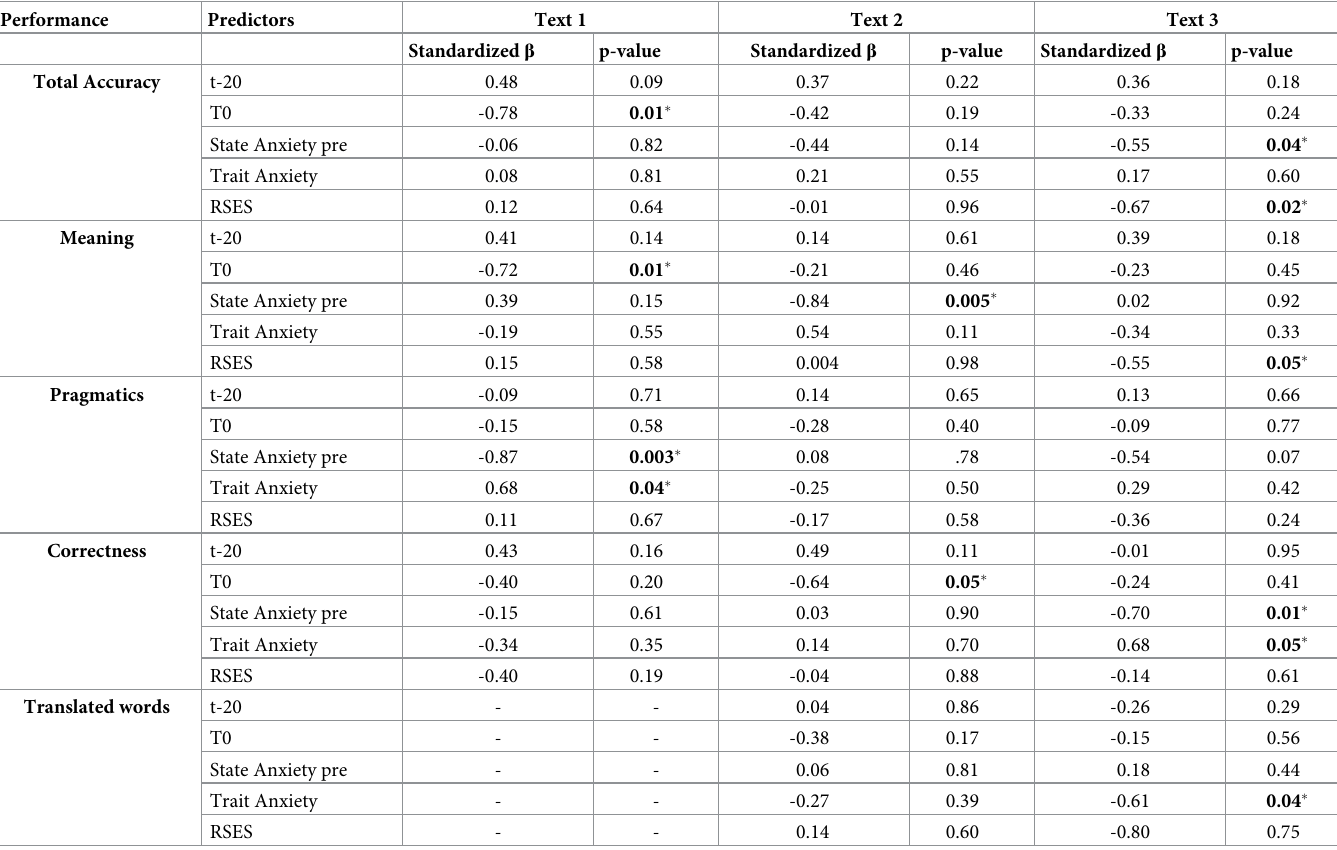
Table 6. Linear regression analyses, considering t-20, t0, state- anxiety pre, trait-anxiety and RSES (Rosenberg Self Esteem scale) as the predictor variables, and text performance as the dependent variable ( � = p � .05). Beta, typified coefficient.